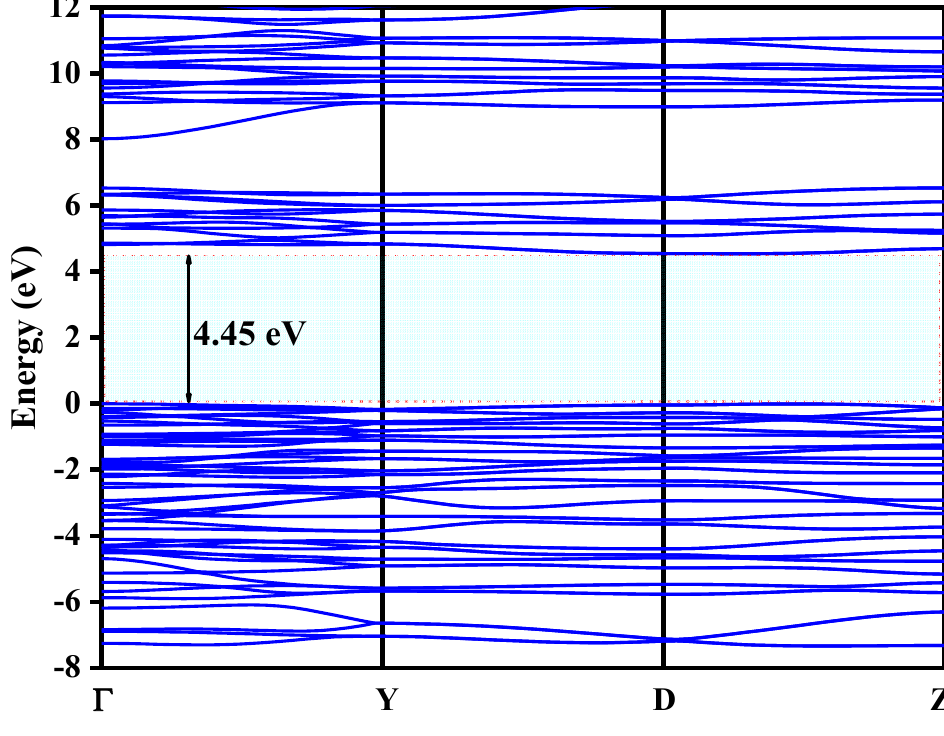
Figure 6. Band structure of bulk BiP-500. The fermi level is set to 0.